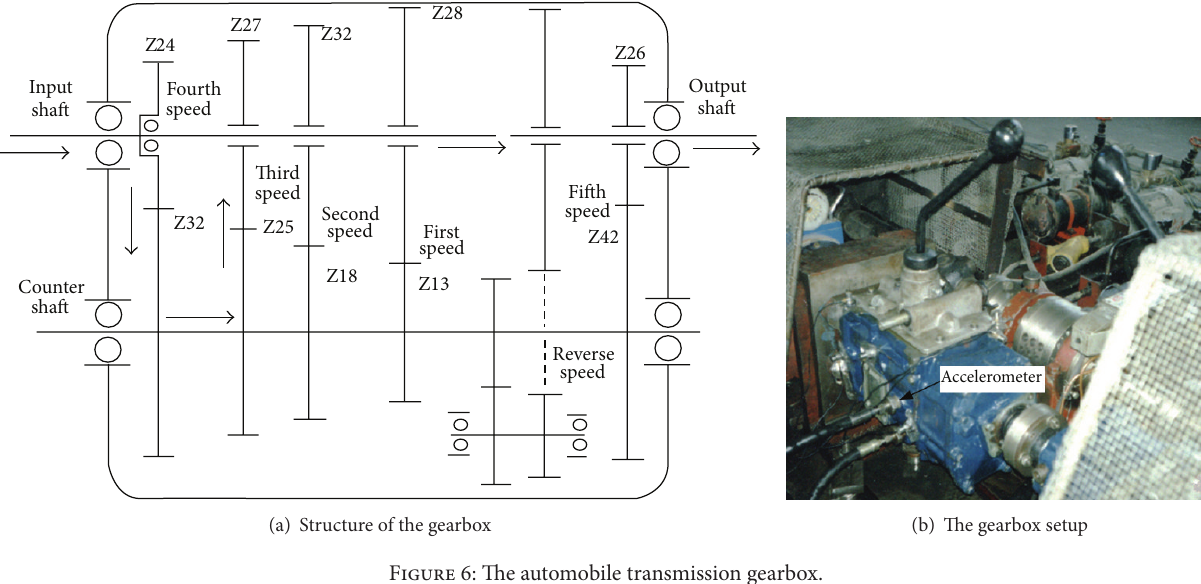
Figure 6: The automobile transmission gearbox.